Question: Condense the content of this figure into a single sentence.
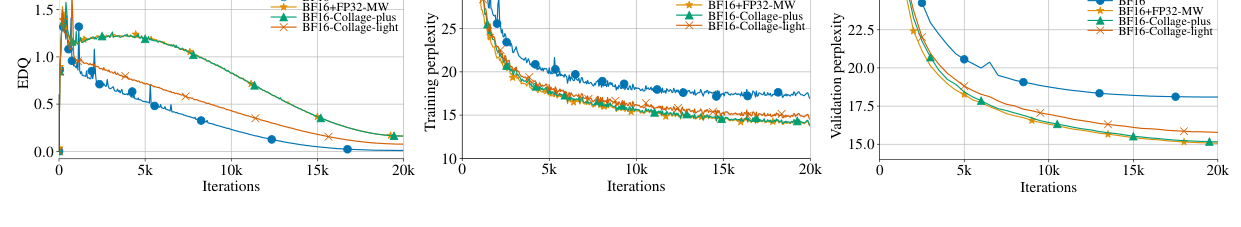
Answer: Pretrainnig progress for GPT 125M with settings described in Section 5.2 and global batch-size=1024, β2 = 0.999. Top-left: EDQ metric vs iterations, top-right: training perplexity vs iterations, and bottom: validation perplexity vs iterations for different precision strategy listed in Table 2. The proposed COLLAGE formations consistently match the FP32 master weights with much less memory footprint and faster training.